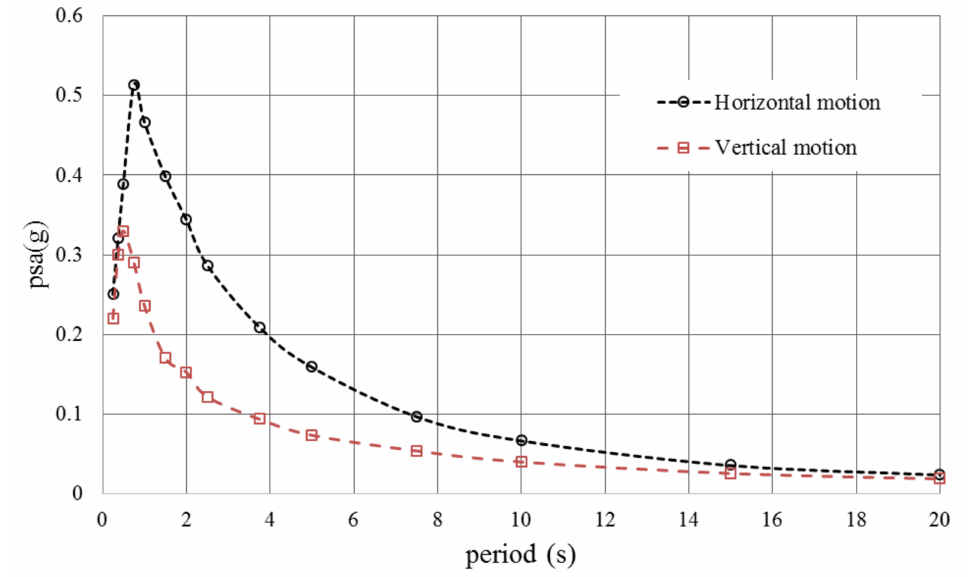
Figure 8. Power spectrum acceleration (psa)–time graph for horizontal and vertical ground